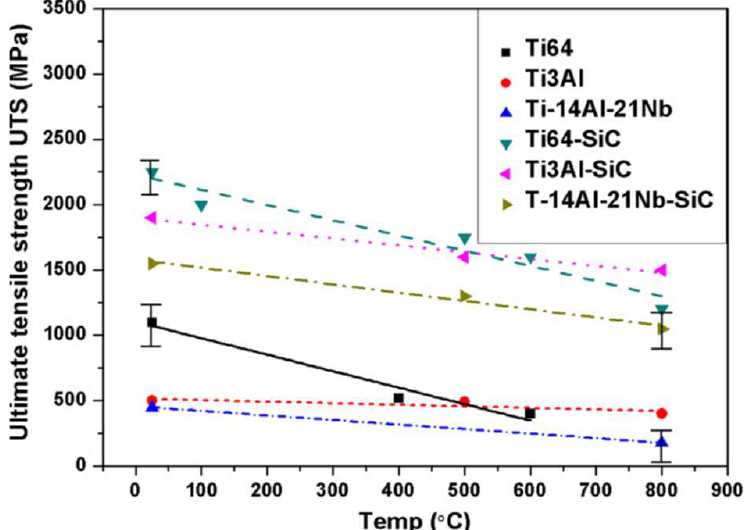
Figure 5. Ultimate tensile strength values of different DRTCs over a temperature range [71].